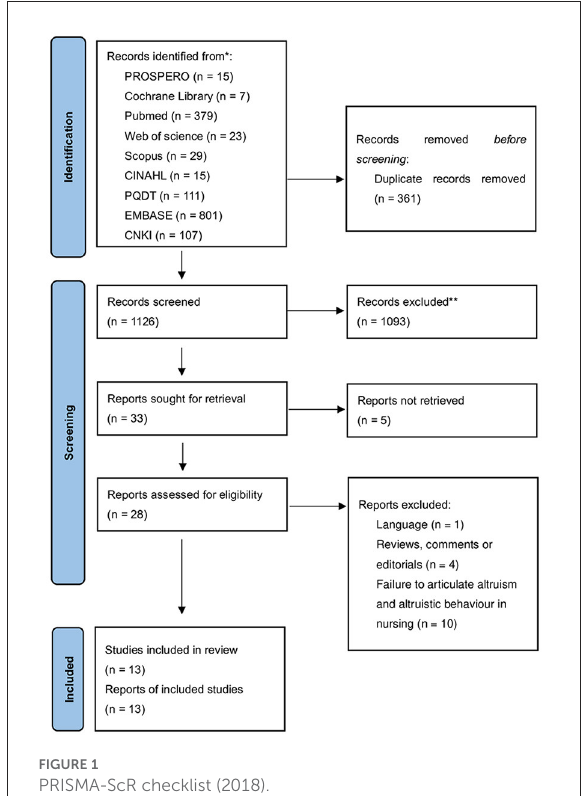
FIGURE1 PRISMA-ScR checklist